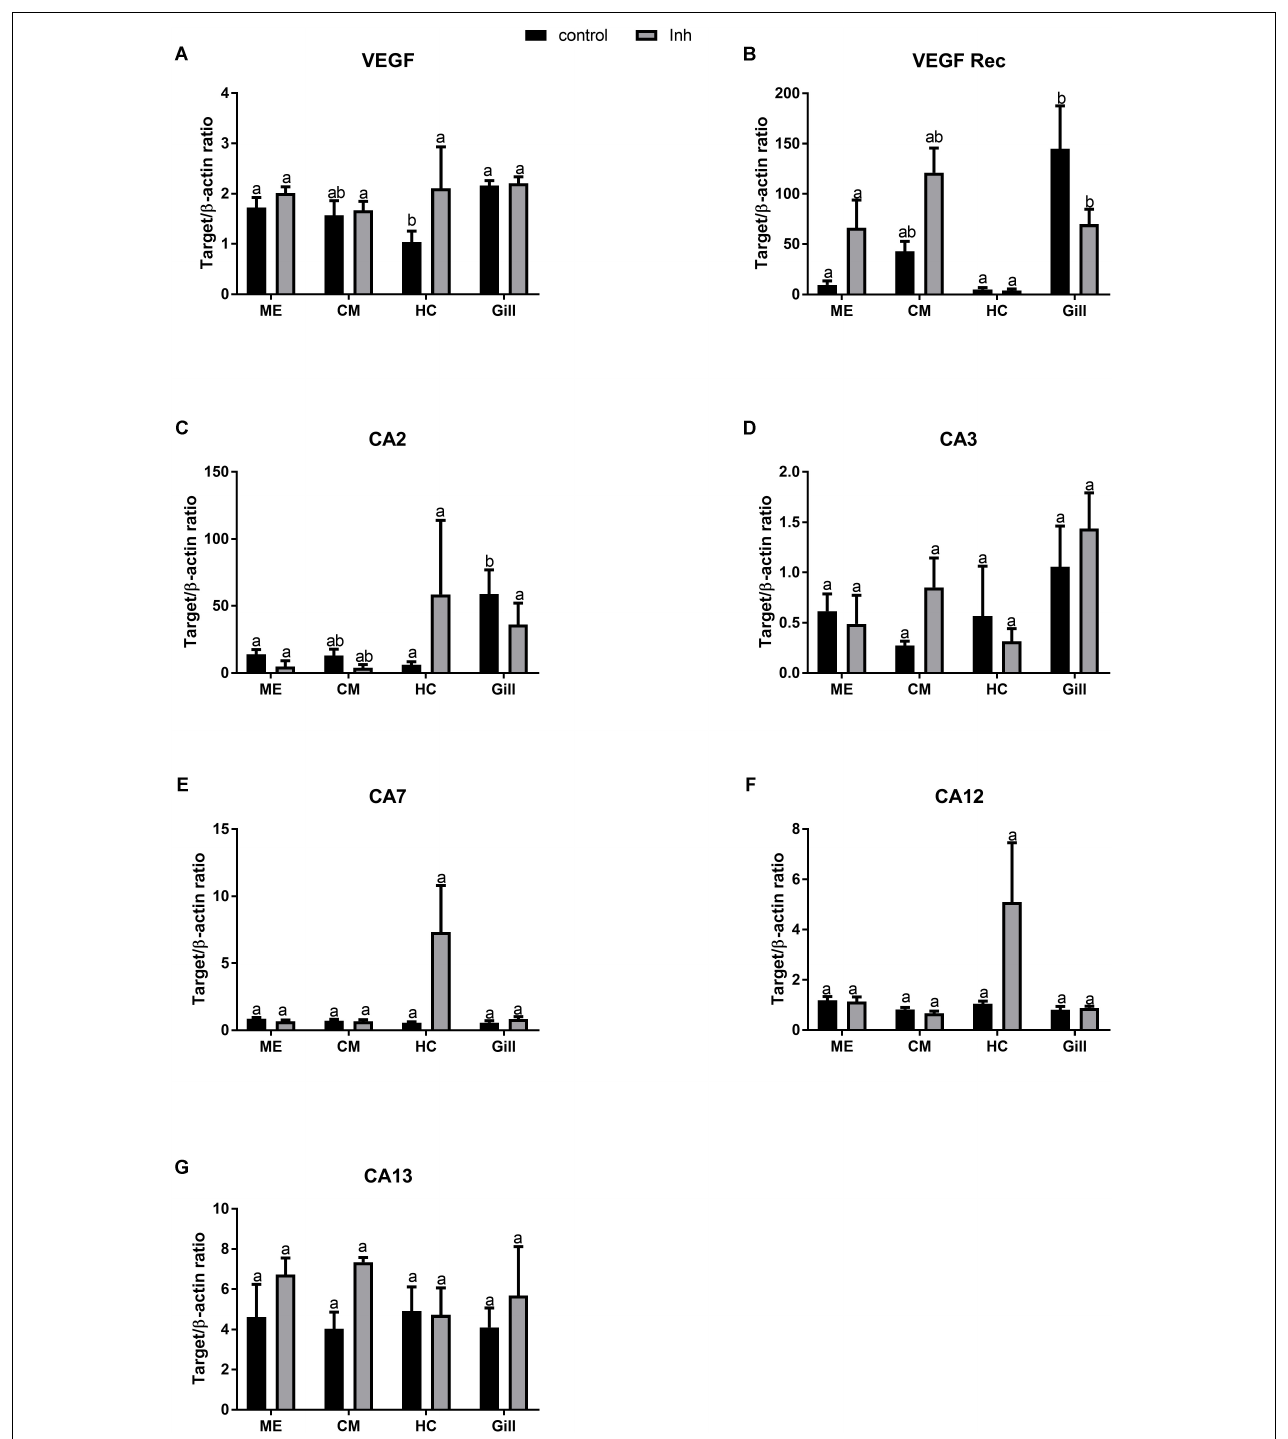
FIGURE 3 | Levels of mRNA expression of VEGF, VEGF receptor, and different isoforms of carbonic anhydrase in tissues of adult C. gigas in response to a 2-week axitinib exposure. Genes: (A) VEGF – vascular endothelial growth factor, (B) VEGF Rec – vascular endothelial growth factor receptor; (C–G) CA2, CA3, CA7, CA12, and CA13 – carbonic anhydrases 2, 3, 7, 12, and 13, respectively. Control – control oysters and Inh – axitinib-exposed oysters. Expression levels in the mantle edge (ME), central mantle (CM), hemocytes (HC), and the gills (Gill) are shown. Different letters indicate significant differences between different tissues under the same treatment conditions (i.e., control or axitinib exposure); columns that do not share a letter are significantly different ( p < 0.05). N = 3–5.